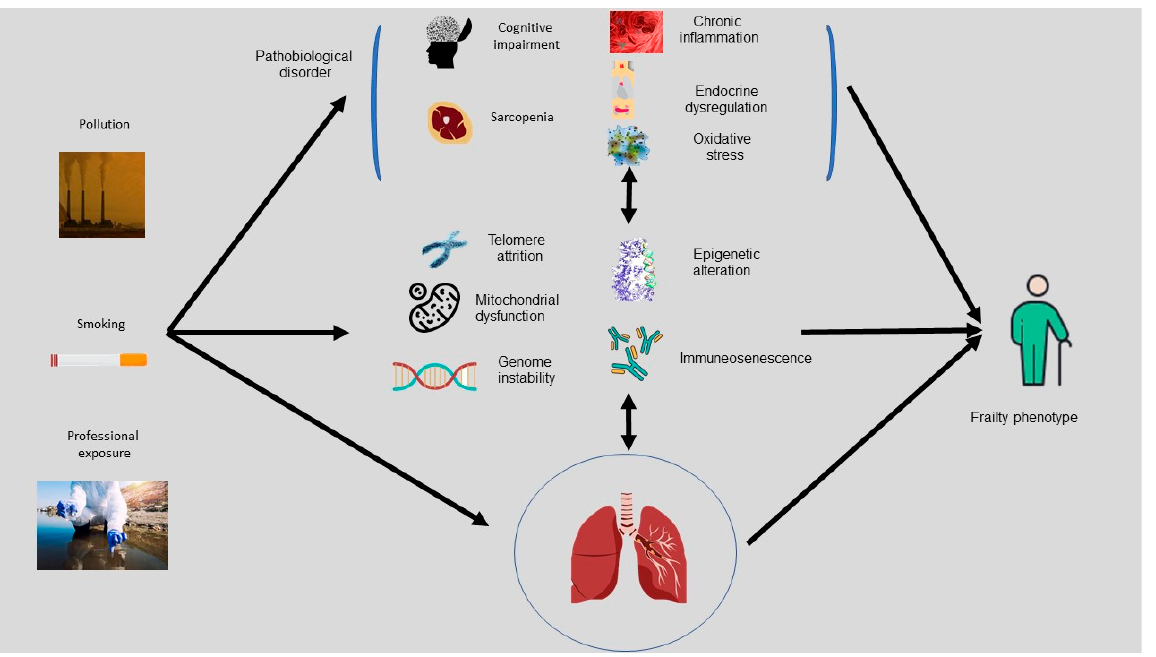
Figure 2. Graphic description of the link between environmental factors, pathobiological disorders, genetic factors, immunosenescence, and frailty.